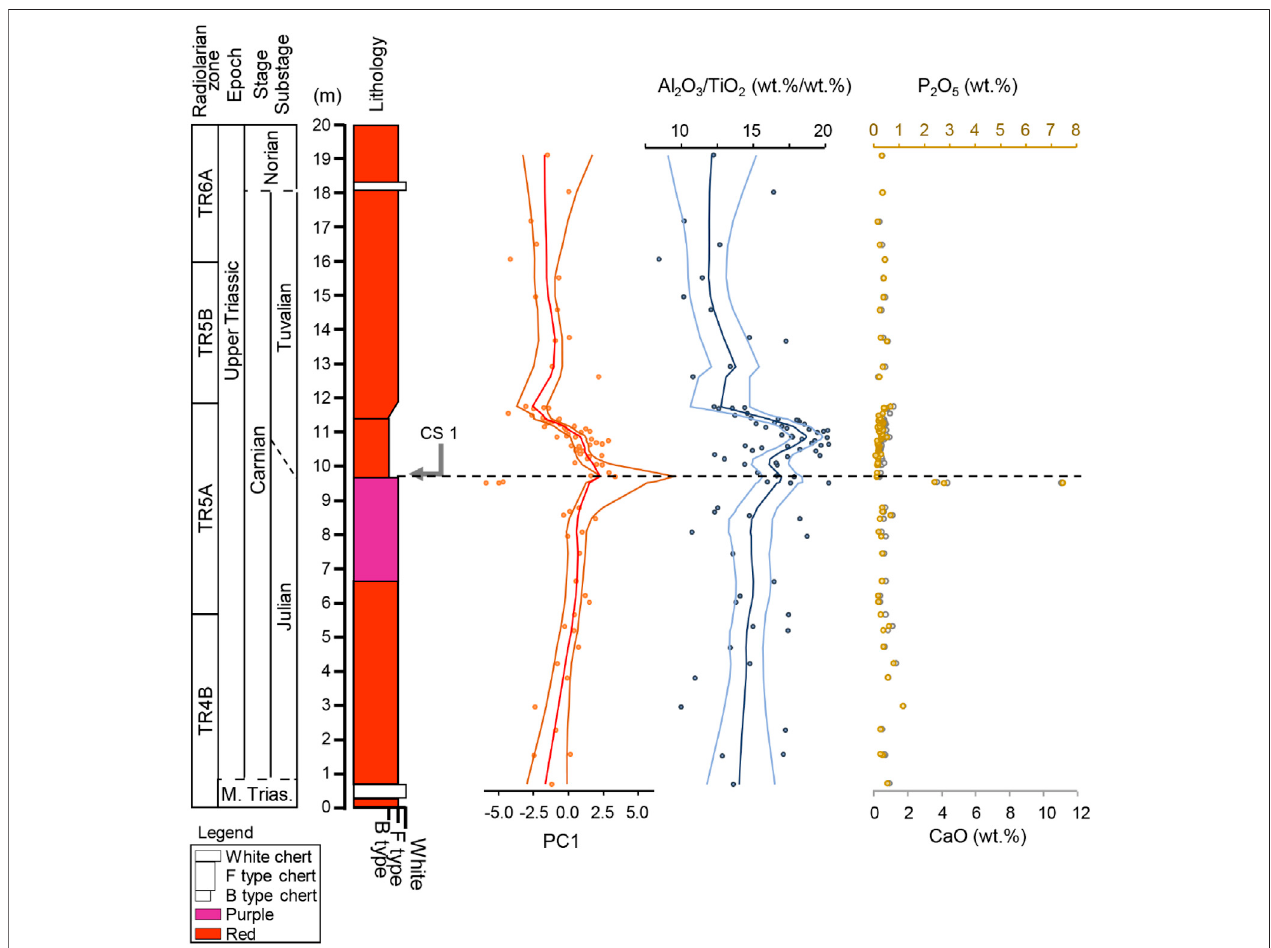
FIGURE9| Thestratigraphicpro fi leofprincipalcomponent1(PC1)scoresandAl 2 O 3 /TiO 2 ratios.LinesindicateLOWESS fi ttingand95%con fi denceintervals.The relativelyhigh PC1 interval ( ca . 1 m thick)can be seenabove the CS-1. Theoutstandingly lowPC1 observed justbelow theCS1 corresponds tothe high CaO and P 2 O 5 samples (Ra39-1, Ra39-2,